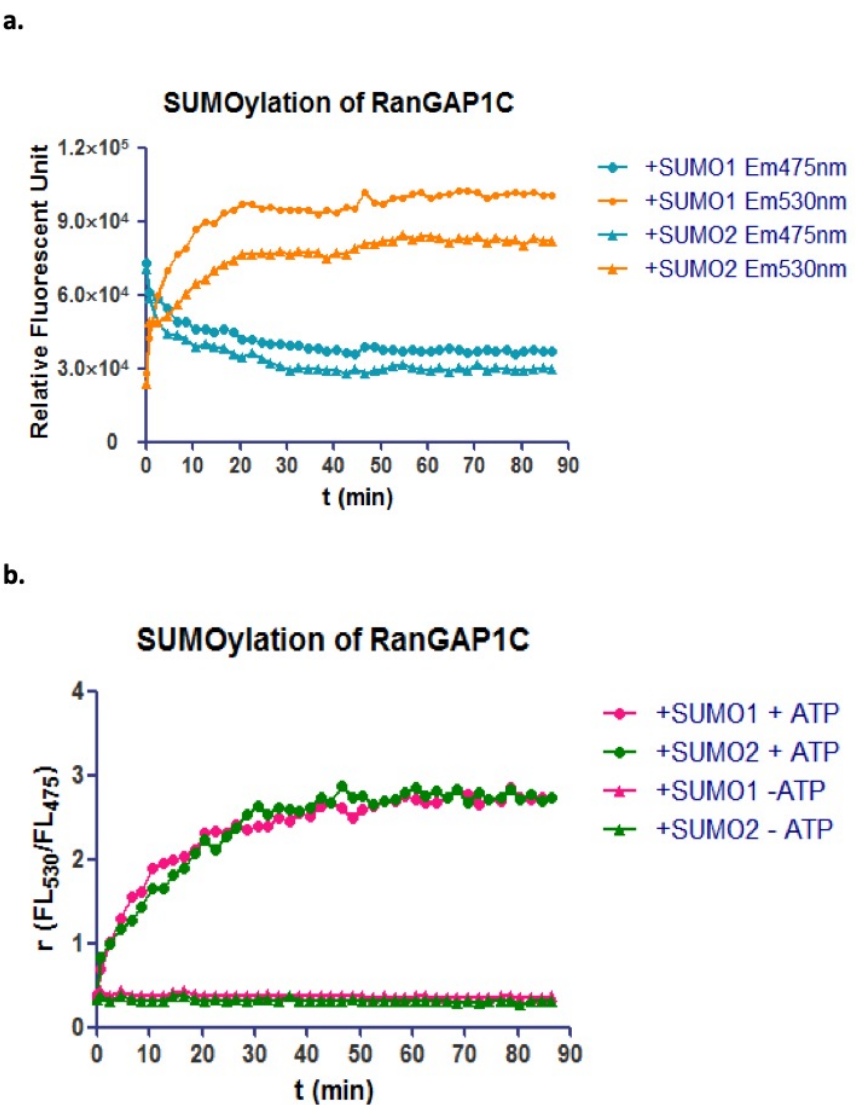
Figure 2. FRET-based protein assay to monitor the SUMO-RanGAP1C conjugation and deconjugation in vitro. ( a ) Fluorescent emission at 475 nm and 530 nm can be used to monitor SUMO1/2 conjugation under the excitation of 414 nm (with ATP). ( b ) Fluorescent emission ratio ( FL 530 /FL 475 ) of SUMO1/2 conjugation under the excitation of 414 nm (with/without ATP).